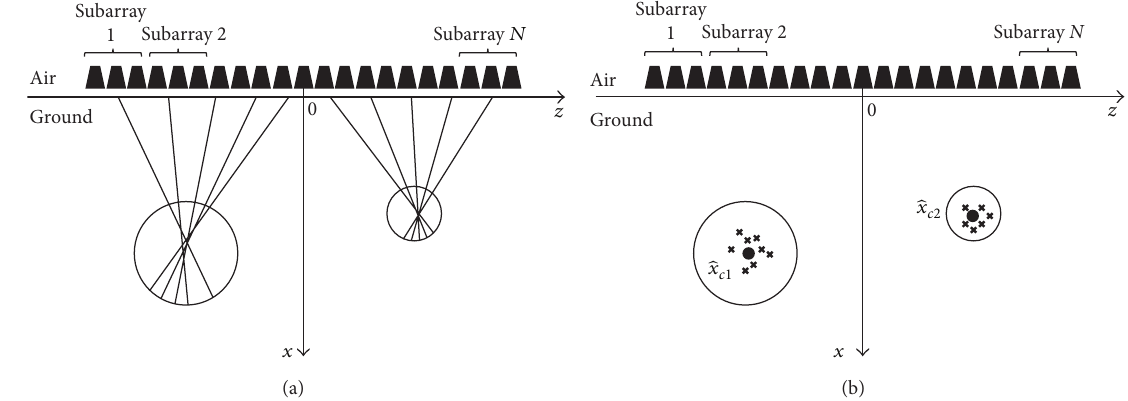
Figure 1: Geometry of the problem with a sketch of (a) the DoA estimated by the subarrays; (b) the pattern of DoA crossings.